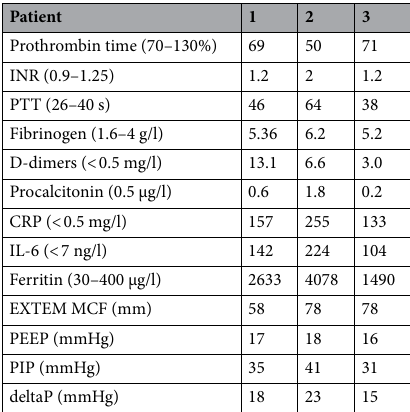
Table 3. Coagulation, inflammatory and ventilatory parameters of three patients who underwent autopsy. PEEP, positive endexspirarory pressure, PIP, Peak inspiratory pressure, deltaP, driving pressure, CRP, C-reactive-protein, IL-6, Interleukin-6, INR, International normalized ratio, PTT Partial Thromboplastin